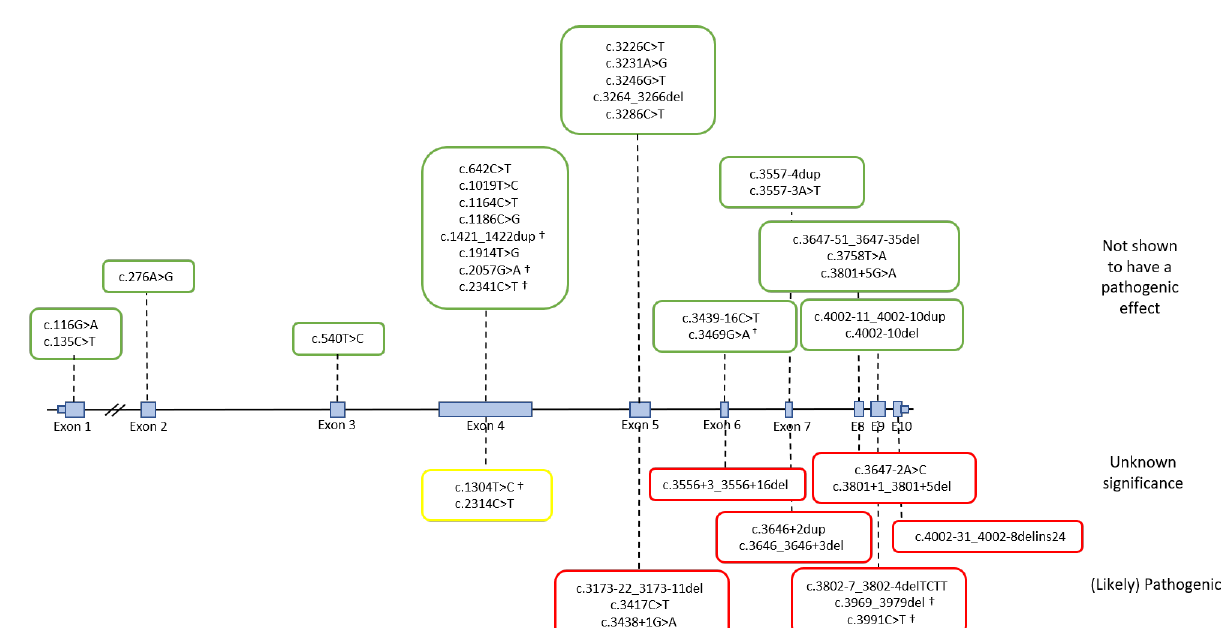
Figure 3. Structure of the MSH6 gene showing the 10 exons and the variants located within or close to them on which published splicing analysis have been performed. The variants have been grouped according to the results of the splicing assays. No effect on splicing (green boxes); incomplete splicing (yellow box); splicing effect (red boxes). Variants marked with † indicates truncating variants or variants shown to have an effect on the protein level.